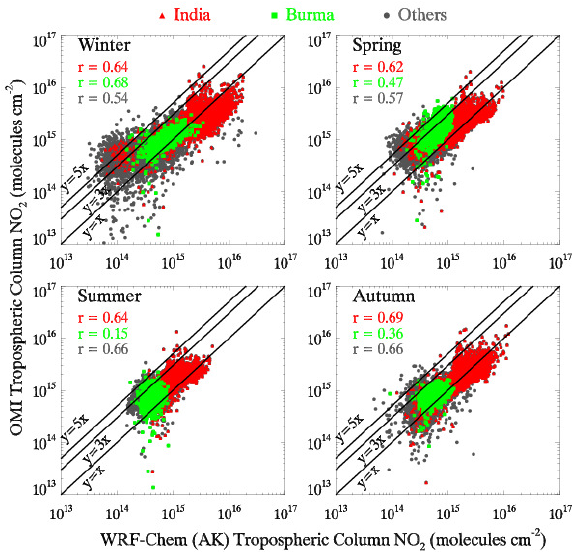
Figure 14: Scatter plot between seasonally averaged WRF-Chem simulated and OMI retrieved 1342 Fig. 14. Scatter plot between seasonally averaged WRF-Chem sim- tropospheric column NO 2 during winter, spring, summer and autumn 2008. Others correspond to 1343 ulated and OMI-retrieved tropospheric column NO 2 during winter, the areas not covered by regions 1-5 shown in Figure 1. The correlation coefficients for each 1344 spring, summer and autumn 2008. Others correspond to the areas region are also shown. 1345 not covered by regions 1–5 shown in Fig. 1. The correlation coeffi- cients for each region are also shown.